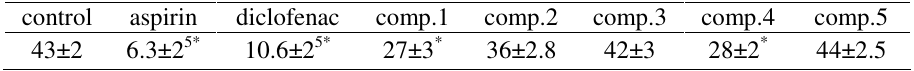
Table 6 . Writhing tests of histidine